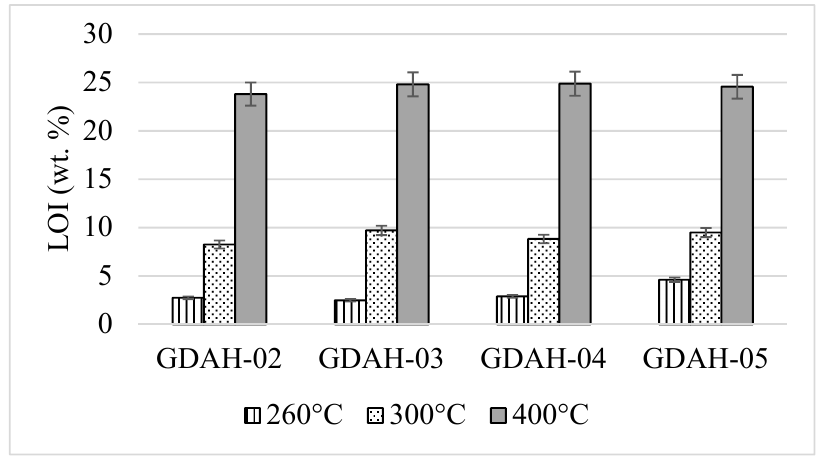
Figure 2. Weight loss on ignition results for the samples calcined at 260, 300, or 400 °C for 2 h.